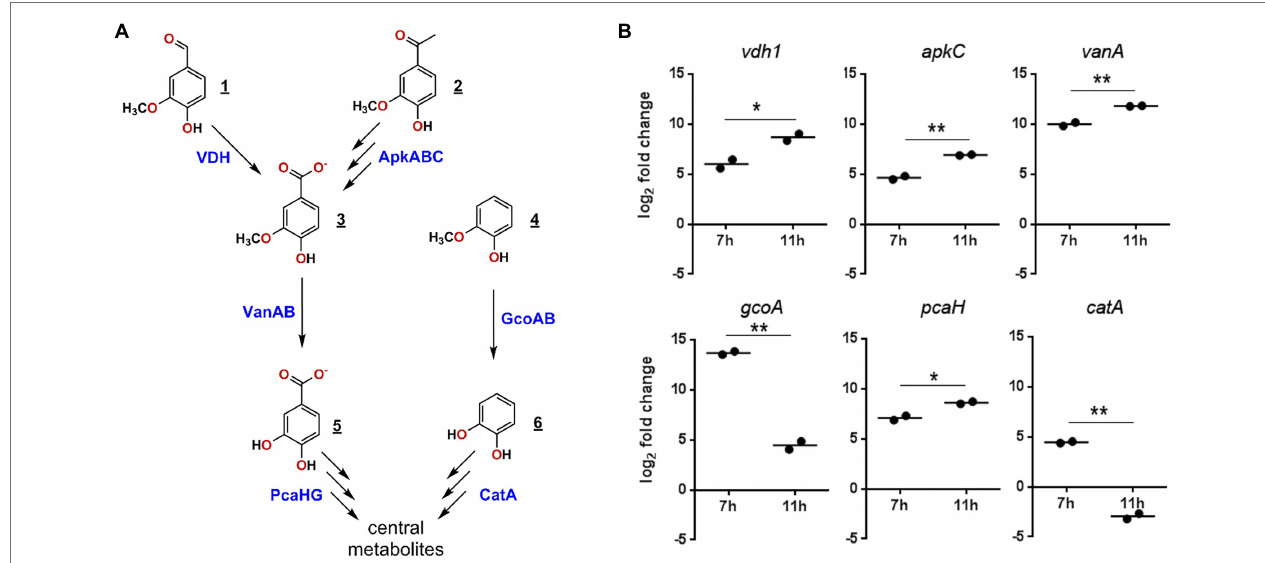
FIGURE 6 | Expression of selected genes in GD02 during growth on a mixture of black liquor compounds. (A) Enzymes predicted to be involved in the catabolism of the major BL monoaromatic compounds and whose genes were investigated using RT-qPCR. Compounds are: 1, vanillin; 2, acetovanillone; 3, vanillate; 4, guaiacol; 5, protocatechuate; and 6, catechol. (B) Expression RT-qPCR of key catabolic genes in GD02 after 7 and 11 h of growth on 1 mM of a mixture of monoaromatic compounds in the same proportion as in the BL extracts. Expression was evaluated using RT-qPCR and are reported as log 2 expression vs. cells growing on 1 mM citrate after normalization to sigA expression. Values are the average of two technical replicates. Significance was determined by t -test, where p values are: * < 0.05, ** <